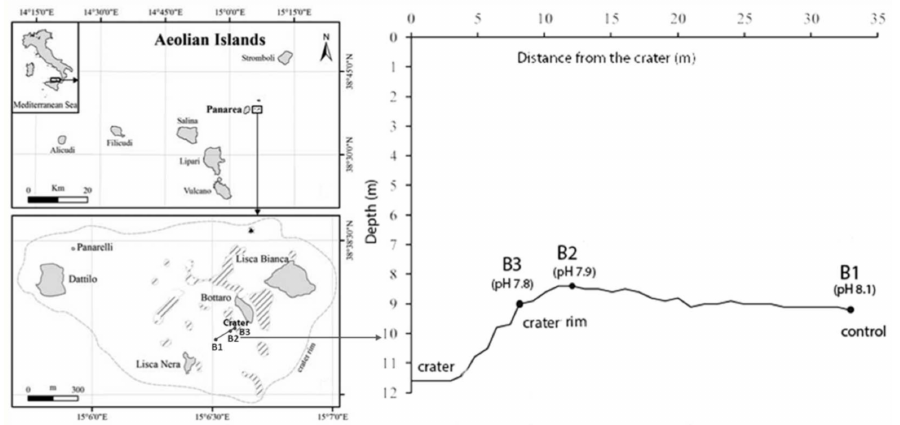
Figure 1. Map of the study area and the defined transect along the pH gradient of Bottaro crater at Panarea Island. (Distance B3–B2, 7 m; distance B3–B1, 35